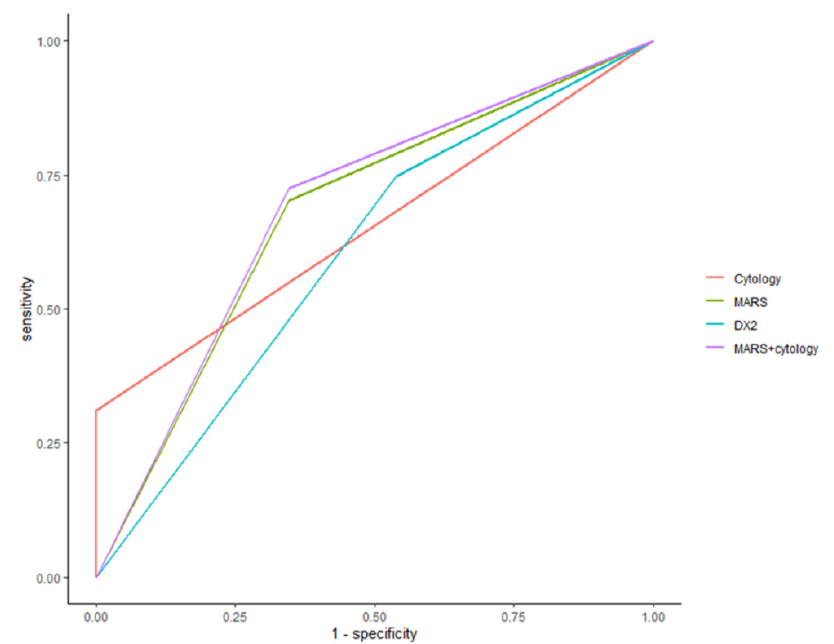
Figure 3. ROC for diagnostic performance according to the test methods. Cytology represents conventional cytology.